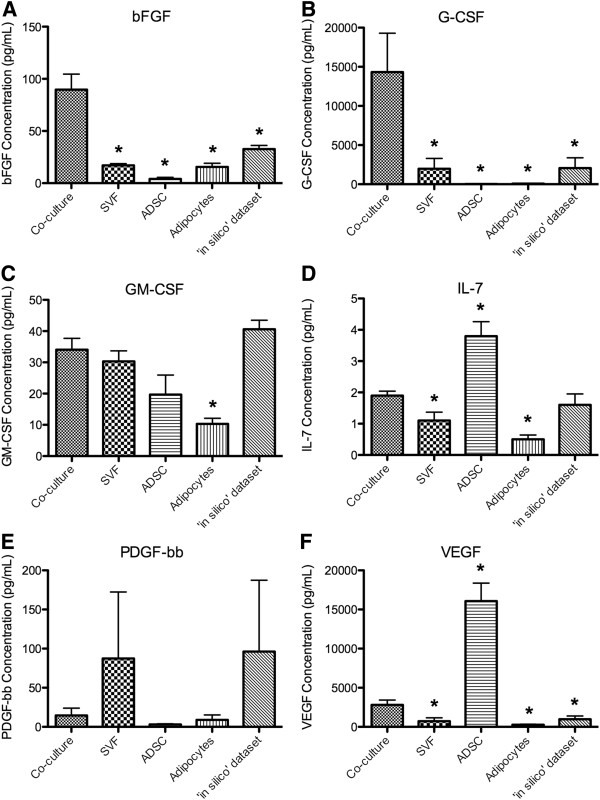
Concentration of growth factors measured in conditioned medium of adipose-derived cell populations. The concentrations of the growth factors, bFGF (A), G-CSF (B), GM-CSF (C), IL-7 (D), PDGF-bb (E) and VEGF (F) were measured in the conditioned medium of the stromal vascular fraction (SVF) co-cultured with adipocytes, SVF, adipose-derived stem cells (ADSC), and adipocytes, as well as the ‘in silico’ dataset. The reported values are the average of 5 biological replicate ± SEM. An * denotes a p-value of ≤ 0.05 when compared to the co-culture dataset.